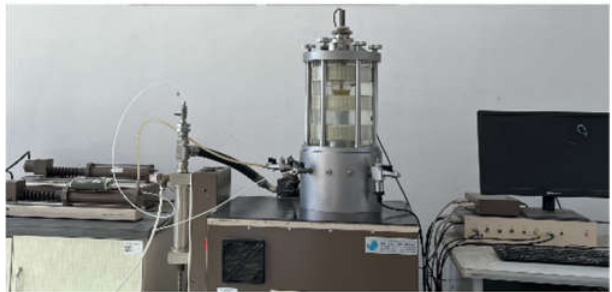
Figure 3. Dynamic triaxial test loading system.